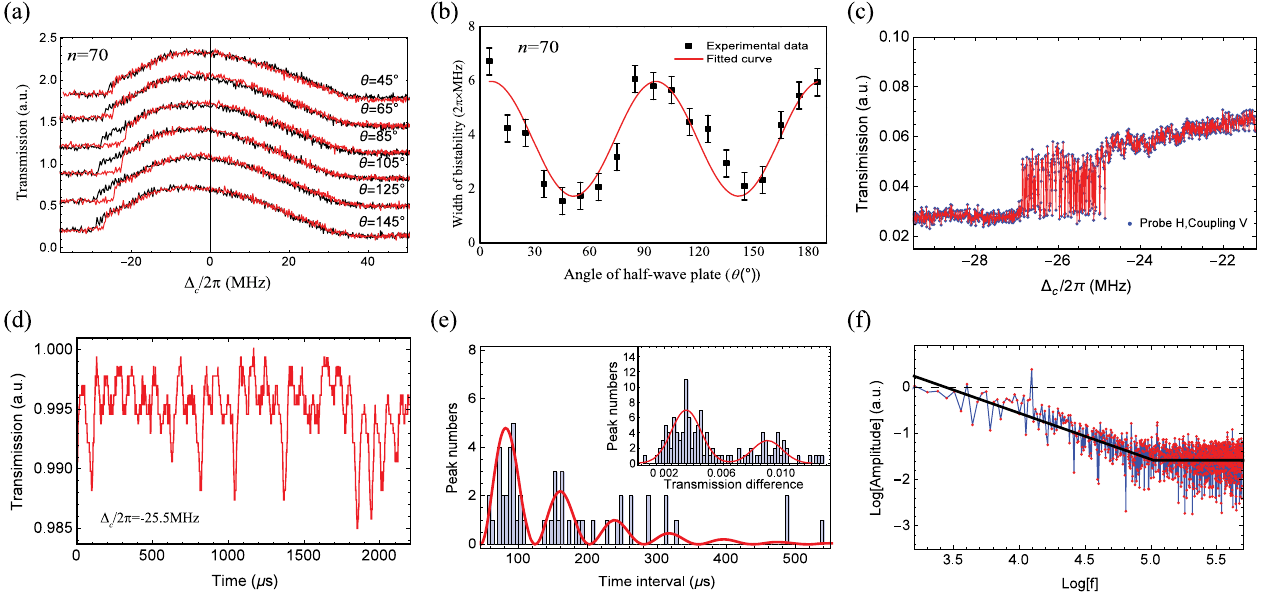
FIG. 6. (a) Transmission spectra vs Δ ( n ¼ 70 ) for different angles of the coupling beam polarization with respect to the probe c ( θ : angle of half-wave plate in coupling beam path, θ ¼ 0 ∘ parallel, 45° orthogonal linear polarization). Red spectra correspond to the scan direction from red to blue detuning and vice versa for black spectra. (b) Width of the hysteresis window in which bistability is observed vs θ . (c) For orthogonal polarization, the bistability window is narrowest, and the system ’ s phase is unstable as Δ = 2 π ¼ − 25 . 5 MHz near the center of the instability window. (e) Histogram of the time intervals (d) Transmission over time for fixed Δ c between phase jumps. Inset: Bimodal distribution of transmission levels subtracted from the maximal transmission. (f) Fourier spectrum of the phase fluctuations. The fits in panels (b) and (e) are guides to the